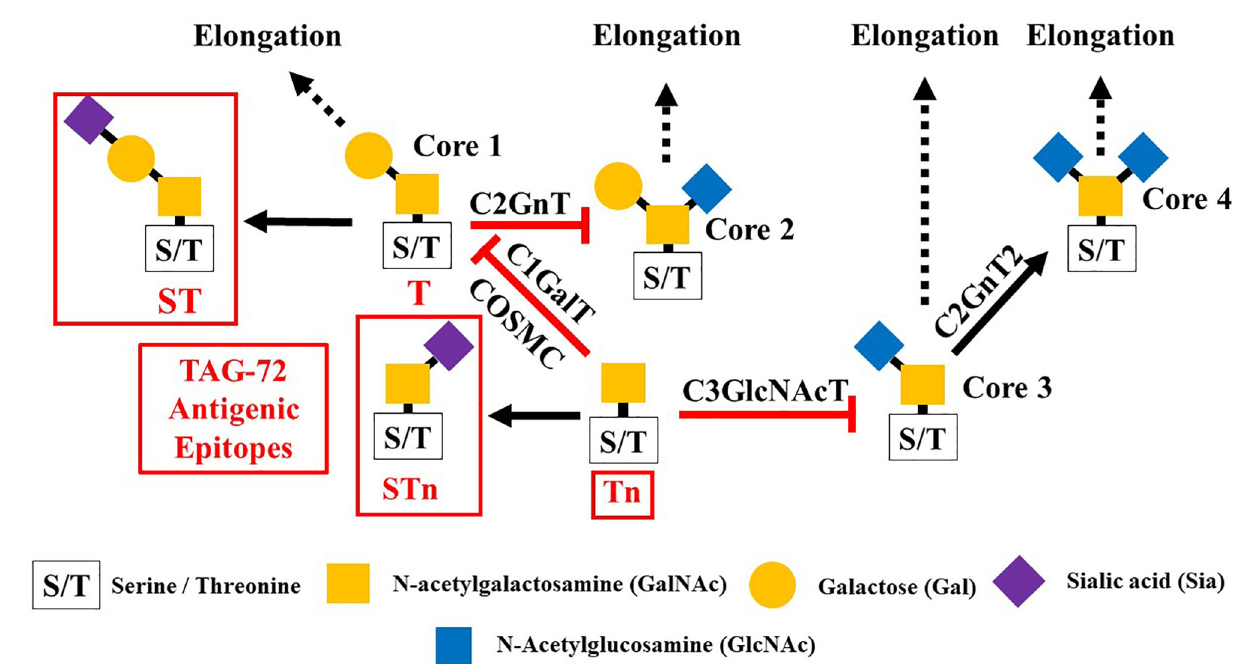
FIGURE 5 | Formation of Core structures in O-linked glycosylation of mucins. Normal O-linked glycosylation begins with the addition N-acetylgalactosamine (GalNAc) to a serine or threonine (S/T) amino acid on core protein. Core 1 Gal-transferase (C1GalT), with the help of the COSMC chaperone protein, adds Gal to the GalNAc-S/T to form the Core 1, which in turn gives rise to Core 2 with the addition of GlcNAc to GalNAc that is catalyzed by Core 2 N-acetylglucosamine transferase (C2GnT). Core 3 N-acetylglucosamine transferase (C3GnT) is the only enzyme that catalyzes the addition of GlcNAc to GalNAc to form Core 3. Core 4 is formed by the addition of another GlcNAc to the GalNAc of Core 3. The subsequent addition of sugars to these Cores [i.e., elongation (dash black arrows)] gives rise to the variable O-glycosylation pattern of mucins. The expression of Tn, STn, T, and ST glycans (red boxes) and loss of Core 3 are often the result of mutations of the transferase genes ( ) associated with the formation of Cores 1, 2, and 3, and the loss of C2GnT activity is also associated with hypermethylation of the gene for the chaperone protein SMC. The loss of function of one or more of these enzymes accounts for the presence of TAG-72 antigenic epitopes (red boxes) present in various